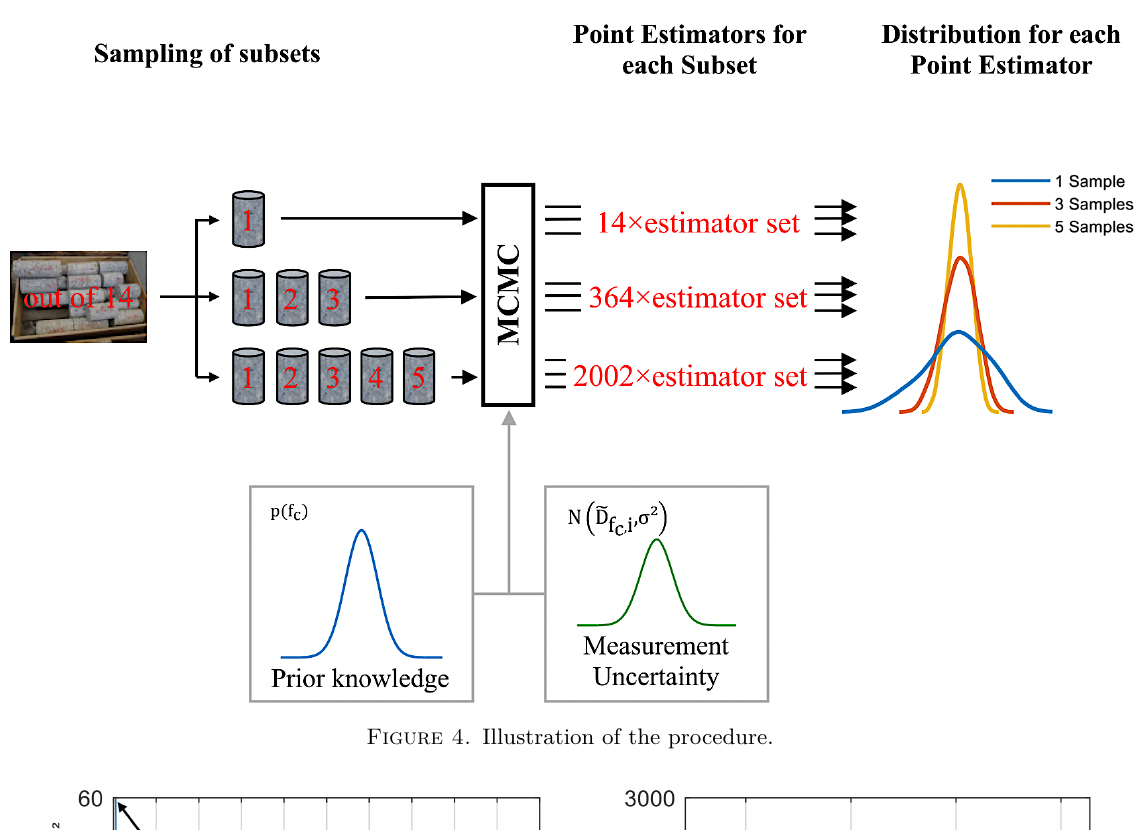
Figure 4. Illustration of the procedure.